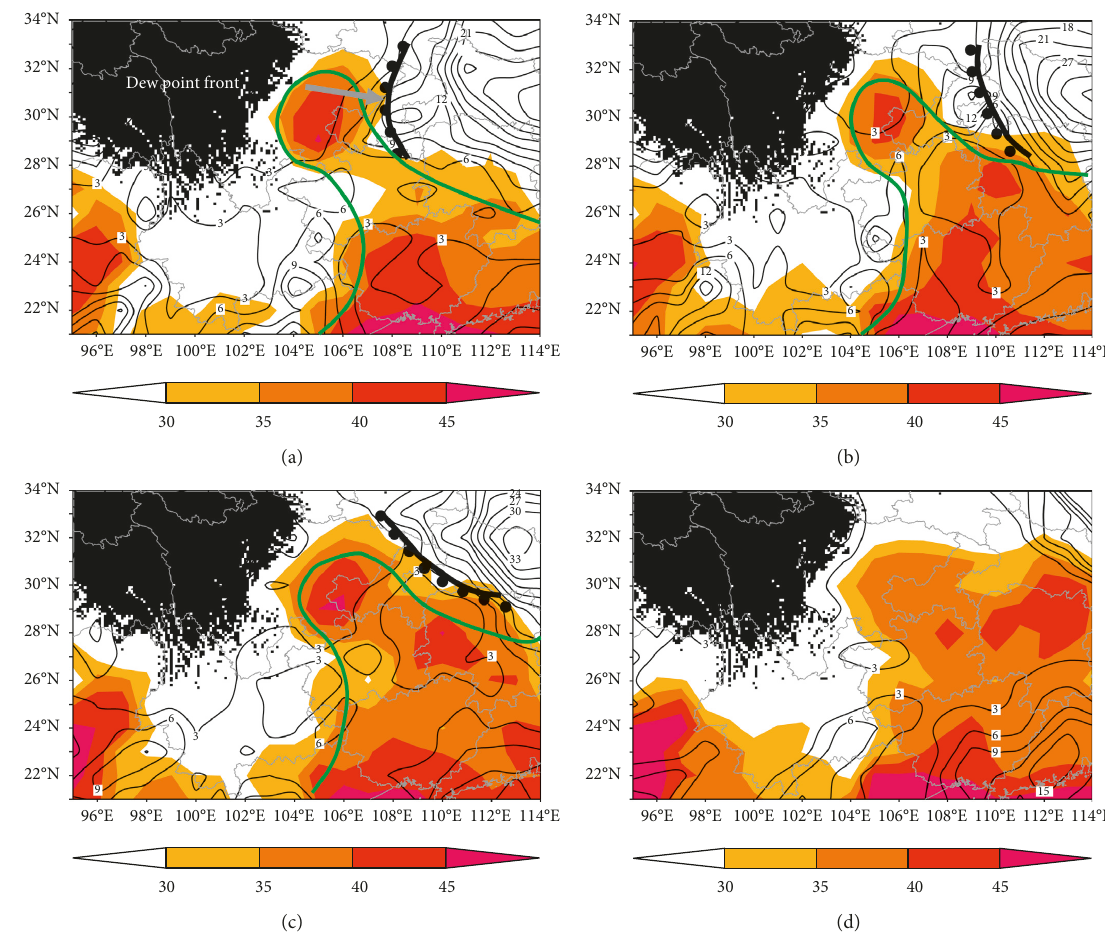
Figure 14: 850hPa temperature dew-point difference (contours, ° C) and the precipitable water (colored area, mm) at (a) 0000 UTC 27 October 2014, (b) 0600 UTC 27 October 2014, (c) 1200 UTC 27 October 2014, and (d) 0000 UTC 28 October 2014.